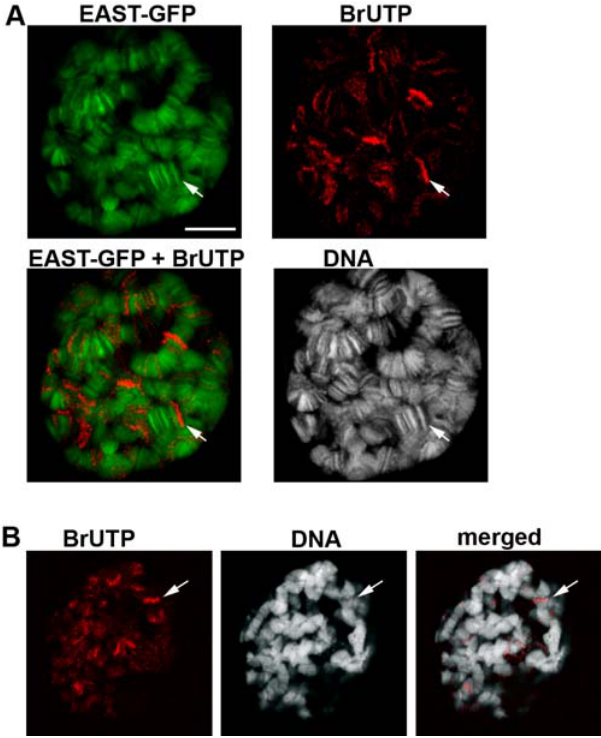
Figure 2. EAST-GFP accumulates in chromosome regions of low transcriptional activity. (A) EAST-GFP (green) is excluded from highly transcribed chromosome regions (arrow) in detergent treated larval salivary glands cells. Run-on transcription was visualized using BrUTP (red). TOPRO3 (white) was used to label DNA. (B) In east hop7 mutants, like in wildtype, regions of high BrUTP incorporation (arrow) are found in interbands. Note that the banding pattern shows less contrast compared to EAST-GFP overexpressing or wildtype (not shown) cells. Bars correspond to 10 m m in all panels.